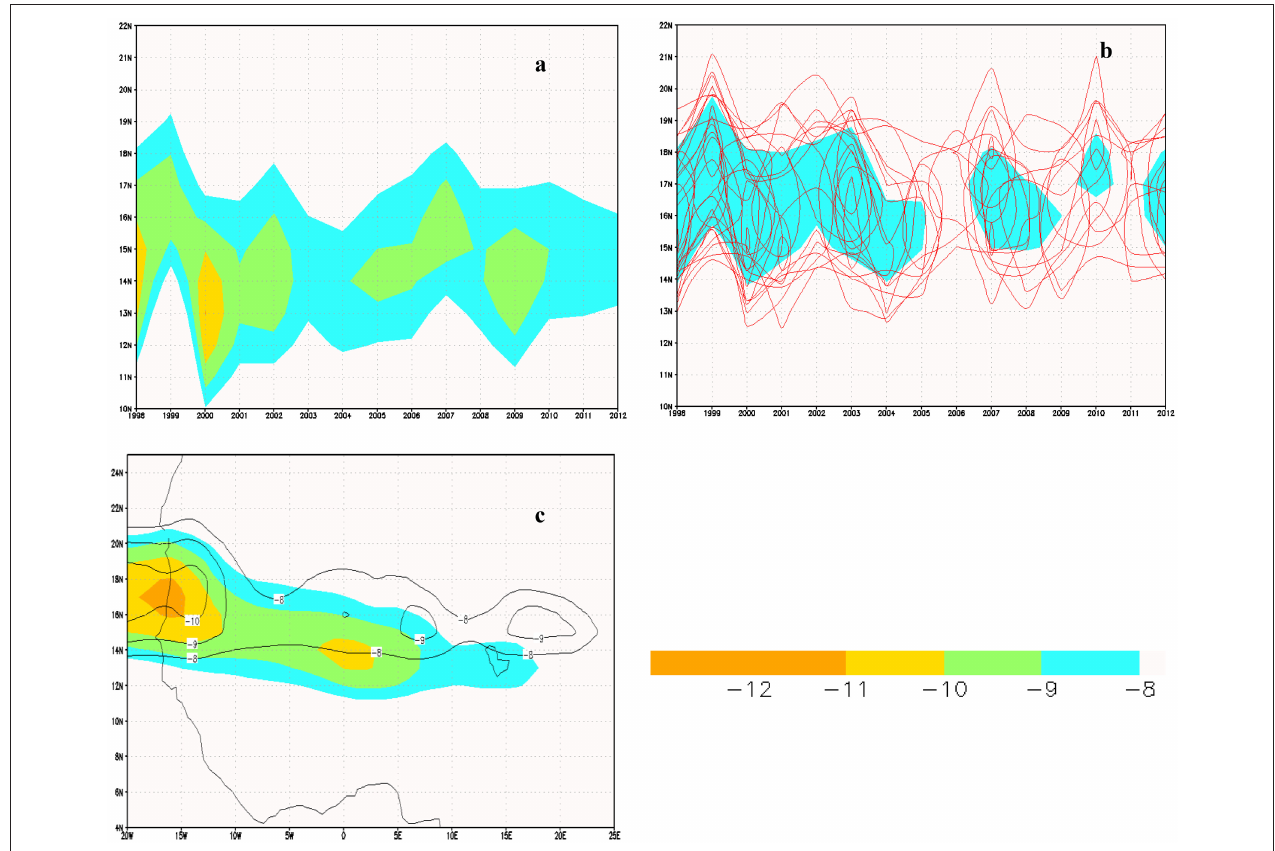
FIGURE 6 | Inter-annual variability of AEJ over West Africa as depicted by zonal wind speed (ms − 1) from (a) the Era-Interim and (b) the ECMWF-S2S model. Shaded in (b) is the Ensemble Mean while the red contours are the Ensemble Members. (c) Spatial distribution of climatology of the AEJ over West Africa from era-interim (shaded) and the ensemble mean (contour) of the ECMWF-S2S forecast.